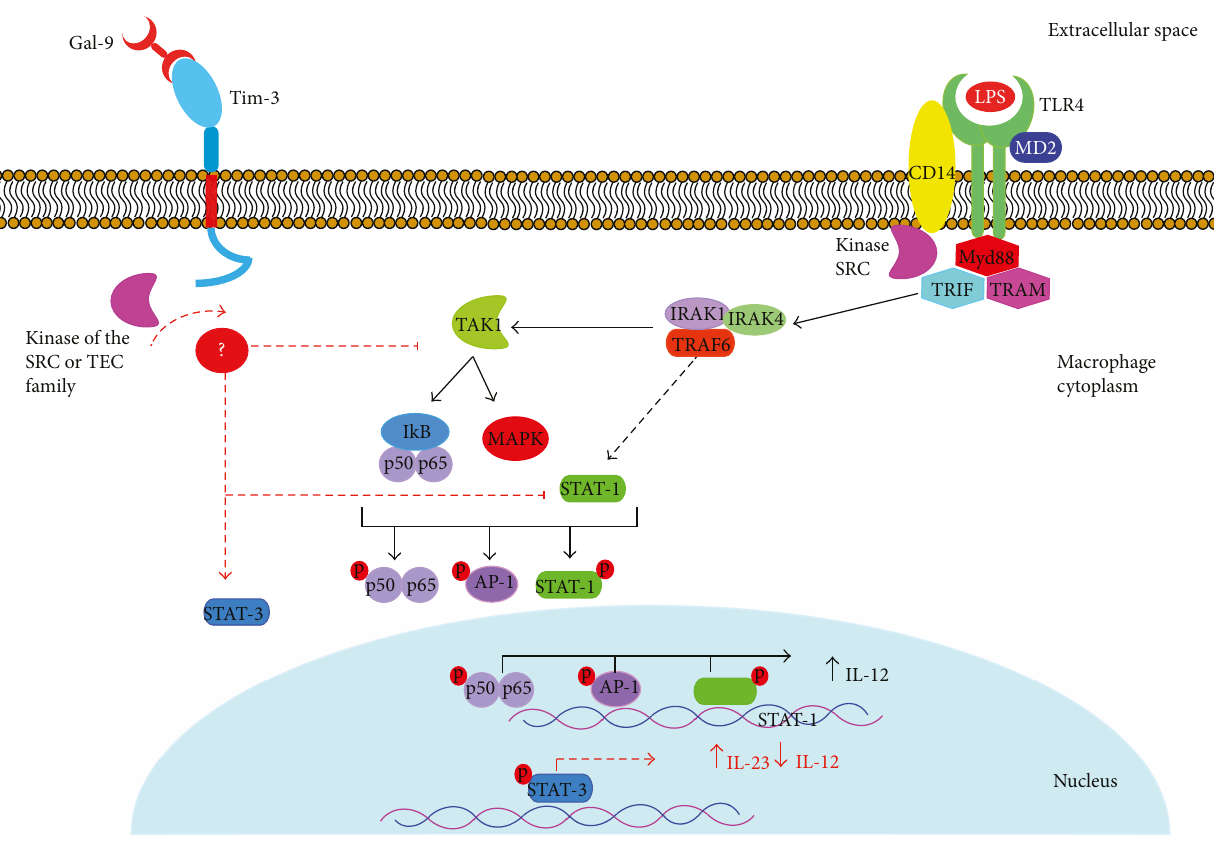
Figure 2: Inhibition mechanism of IL-12 production through interaction of TIM-3 and Gal-9. Graphic representation of the TLR4-signaling pathway (black arrows) when activated by LPS (to simplify, not all proteins involved are shown), which induces phosphorylation of diverse nuclear factors, such as NF- κ B (p50-p65), AP-1, and STAT1. These nuclear factors induce production of proin fl ammatory molecules like IL- 12. When TIM-3 interacts with Gal-9, phosphorylation of the intracellular portion of TIM-3 is induced and activates the regulatory pathway mediated by this protein. While we do not yet know the precise inhibition mechanism in macrophages, studies have identi fi ed a decrease in STAT1 phosphorylation and an increase in STAT3 phosphorylation (red arrows). The result of this change is reduced IL-12 production and increased IL-23